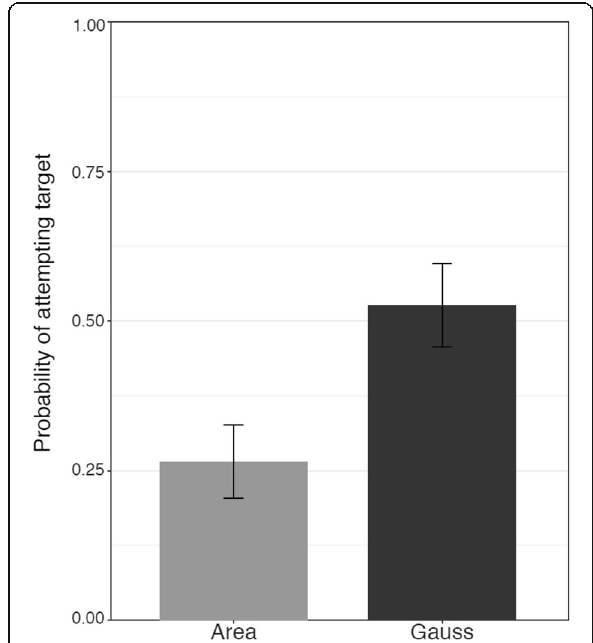
Fig. 5 The probability of adopting the area strategy or the Gauss strategy when exposed to both. Error bars display standard